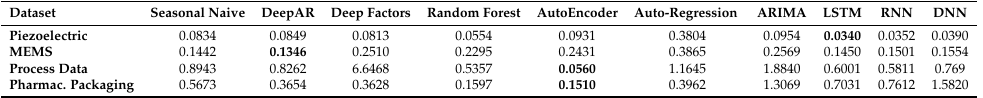
Table 1. Results for forecasting (RMSE; the lower the better) for every testbed. For each forecasting model, we choose the model with the best performance from all its model variants. We observe that the best forecasting model is task-dependent (i.e., the best model is varying depending on each dataset type). The values with bold text are those with the best performances.